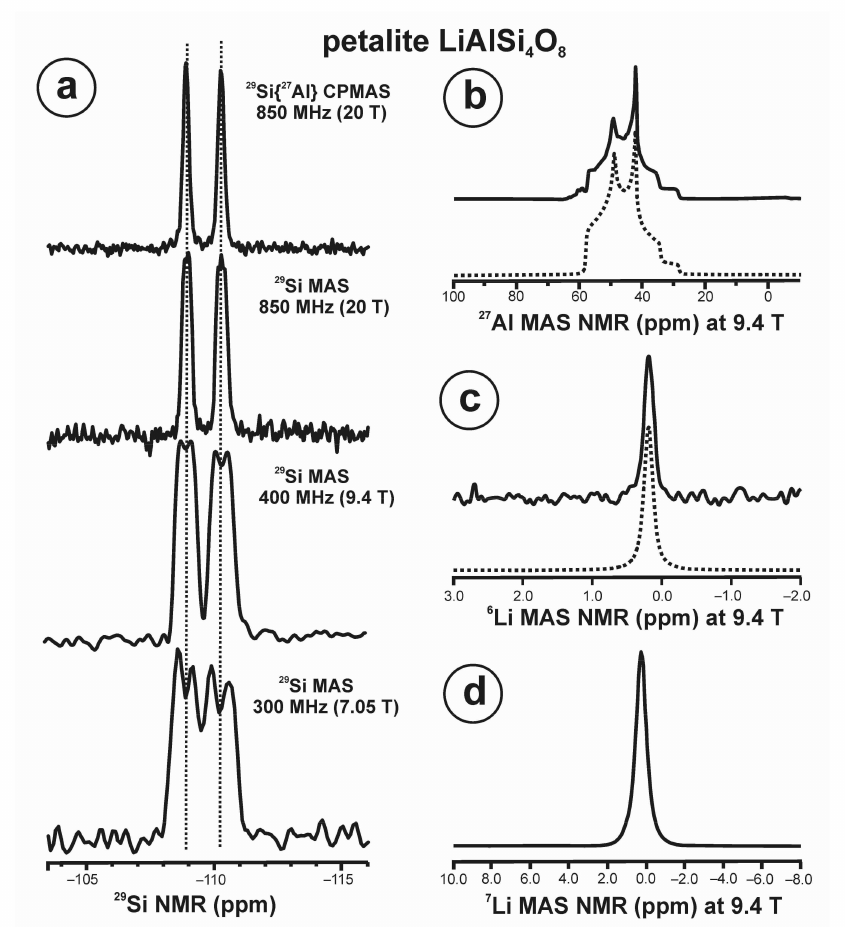
Figure 11. The MAS NMR spectra of petalite LiAlSi 4 O 8 from specimen Brazil . ( a ) The 29 Si spectra as 29 Si{ 27 Al} at 20 T, single pulse at 20 T, single pulse at 9.4 T, and single pulse at 7.05 T. ( b ) The 27 Al spectrum at 9.4 T. ( c , d ) are the 6 Li and 7 Li spectra at 9.4 T, respectively. See the NMR parameters in